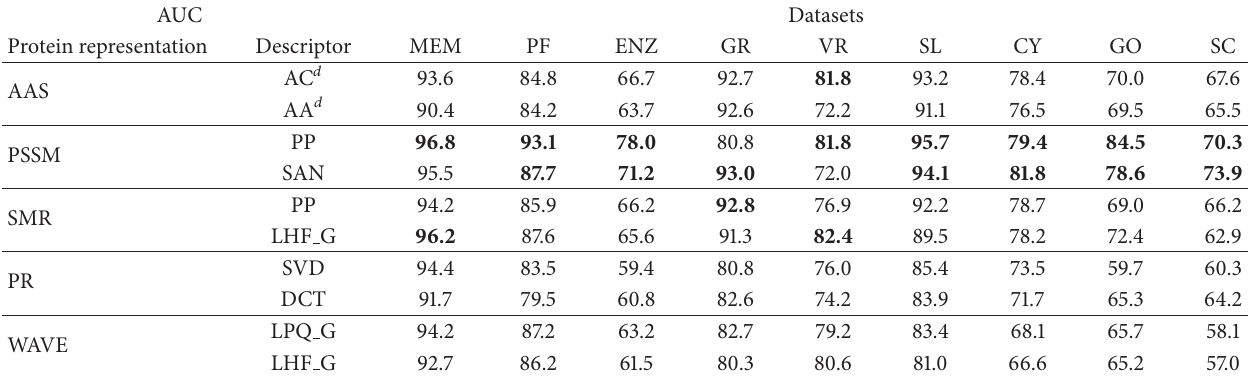
Table 5: Comparison in terms of AUC in multiclass problems.